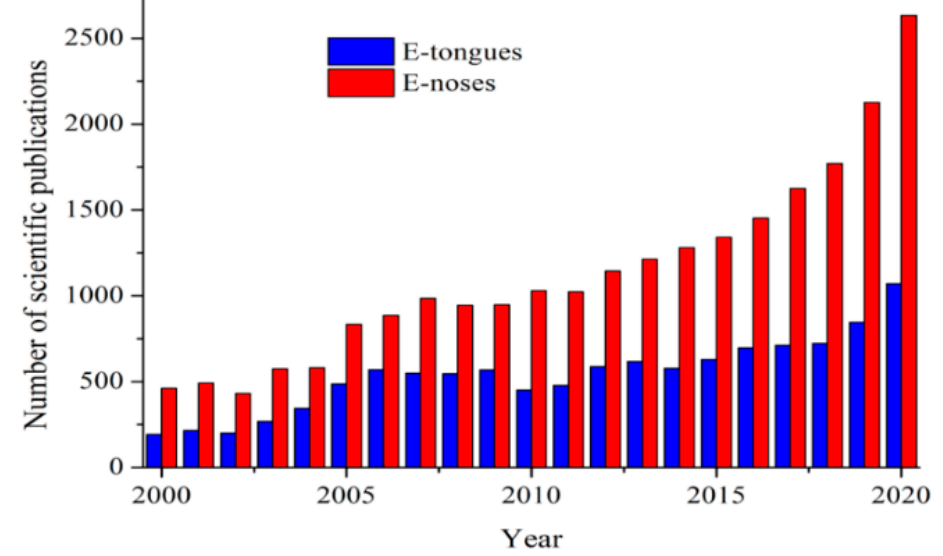
Figure 3. Number of scientific publications containing “electronic tongues” (E-tongues) and “electronic noses” (E-noses) terms published per year. Information obtained from Science Direct database (2021).